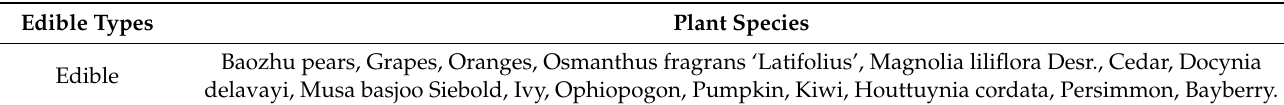
Table 1. Types of edible landscape plants in Chenggong University